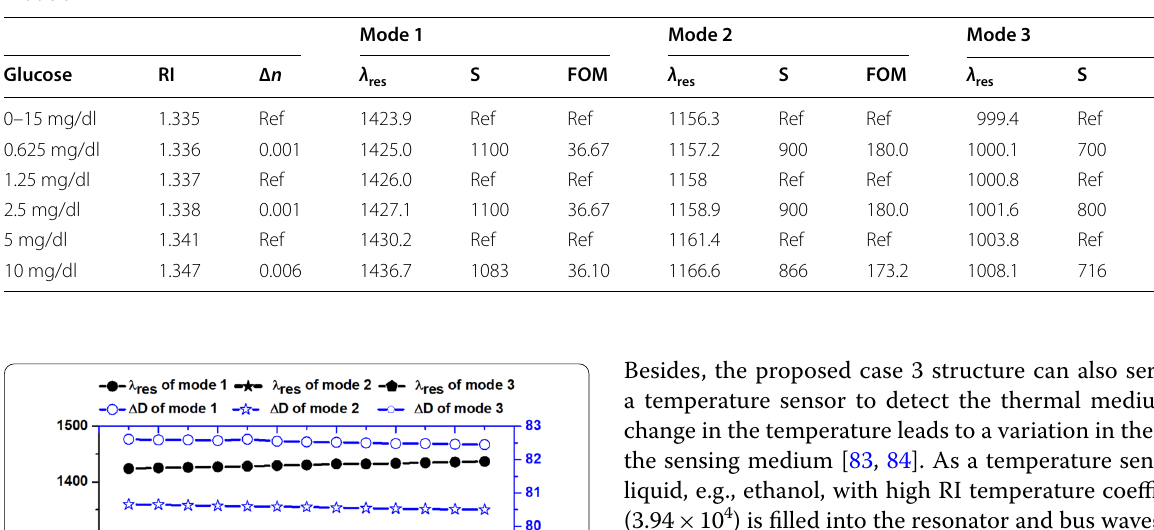
Table 4 λ (nm), S (nm/RIU), and FOM (1/RIU) of case 3 structure in different GC of patient urine samples corresponding to mode 1 to res